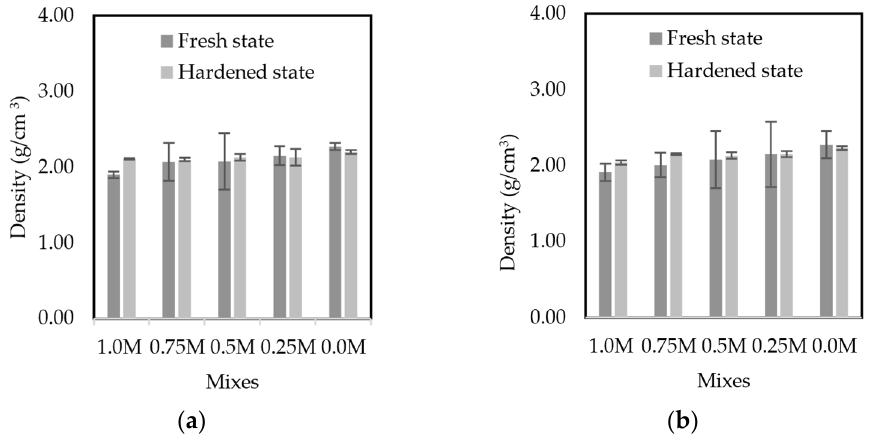
Figure 7. Fresh and hardened-state densities of: ( a ) OAA mixes and ( b ) CAA mixes.